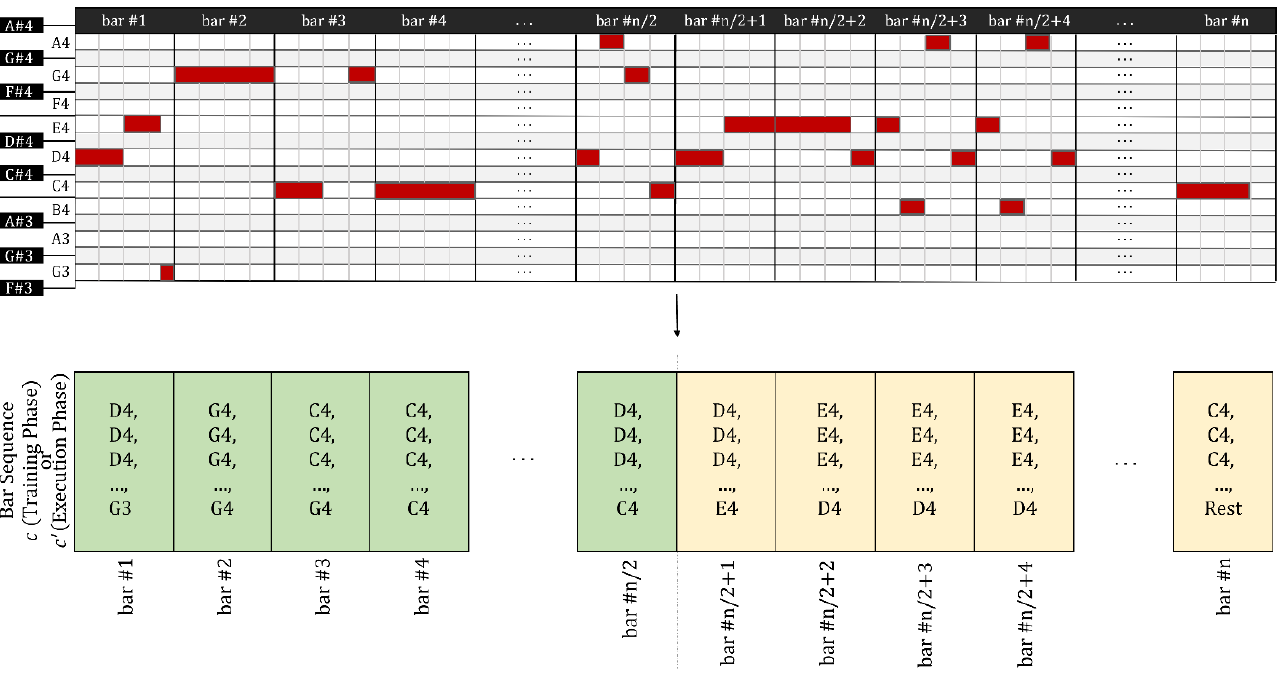
Figure 4. Conversion process of the note converter.